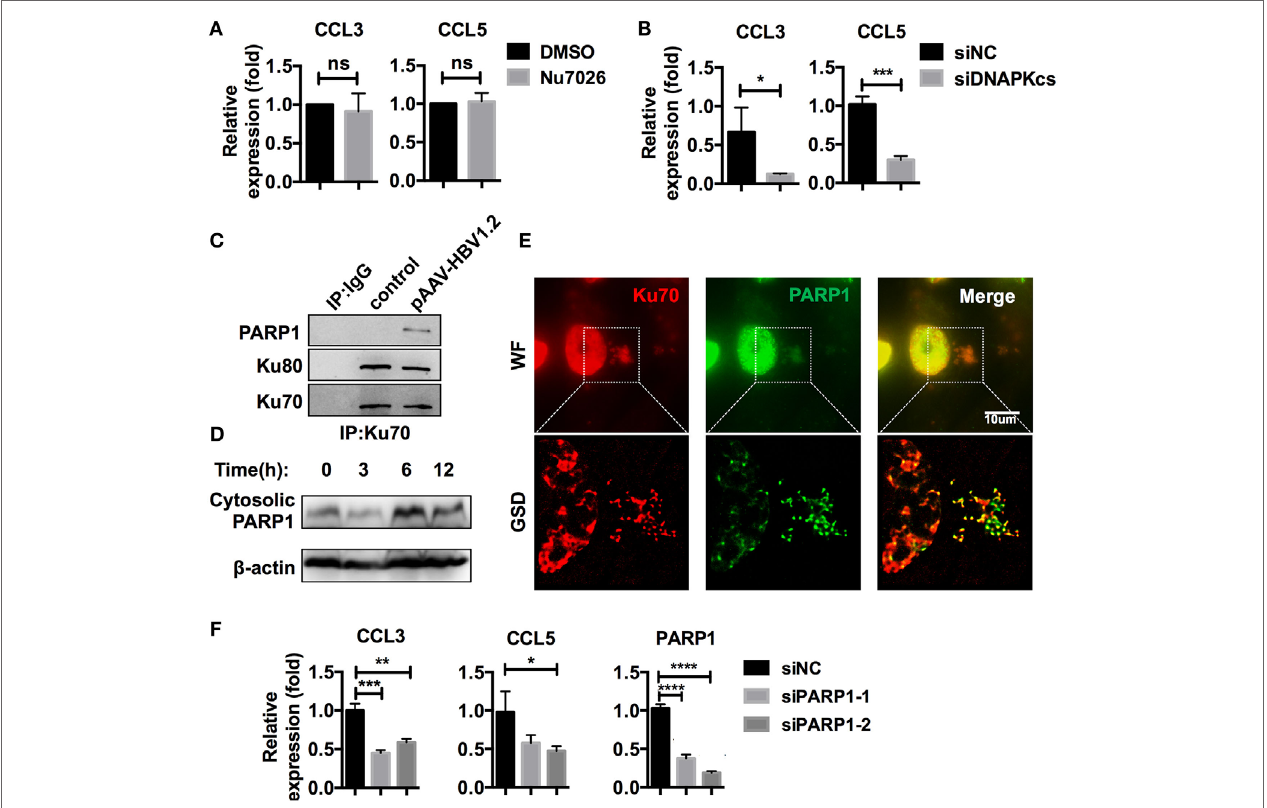
FigUre 6 | Ku70/80 elicits Dna-PKcs and ParP-1 to promote ccl3 and ccl5 expression . (a) SK-Hep-1 cells were pre-treated with Nu7026 (10 μ M, DMSO as a control) 24 h before transfection with pAAV-HBV1.2 plasmid. Forty-eight hours post-transfection, the cells were harvested using RT-PCR and real-time qPCR assay ( n = 3). (B) SK-Hep-1 cells were treated with RNAi against DNA-PKcs 24 h before pAAV-HBV1.2 plasmid transfection. Forty-eight hours post-transfection, the cells were harvested using RT-PCR and real-time qPCR assays ( n = 3). (c) SK-Hep-1 cells were transfected with pAAV-HBV1.2 plasmid (medium as control). Six hours later, Ku70 was immunoprecipitated with antibody, with IgG1 as a negative control. The samples were analyzed by Western blotting. (D) pAAV-HBV1.2 plasmid was transfected into SK-Hep-1 cells. The cells were harvested 0–24 h post-transfection, and the cytosolic proteins were extracted using Western blot. (e) SK-Hep-1 cells were transfected with pAAV-HBV1.2 plasmid. Six hours later, the cells were fixed and immunofluorescently labeled. Subsequently, the cells were imaged under wide-field and GSD super-resolution modes. Scale bars: 10 μ m. (F) SK-Hep-1 cells were treated with Ku70 RNAi 24 h before transfection of pAAV-HBV1.2 plasmid. Subsequently, RT-PCR and real-time qPCR were performed to determine the mRNA expression changes ( n =